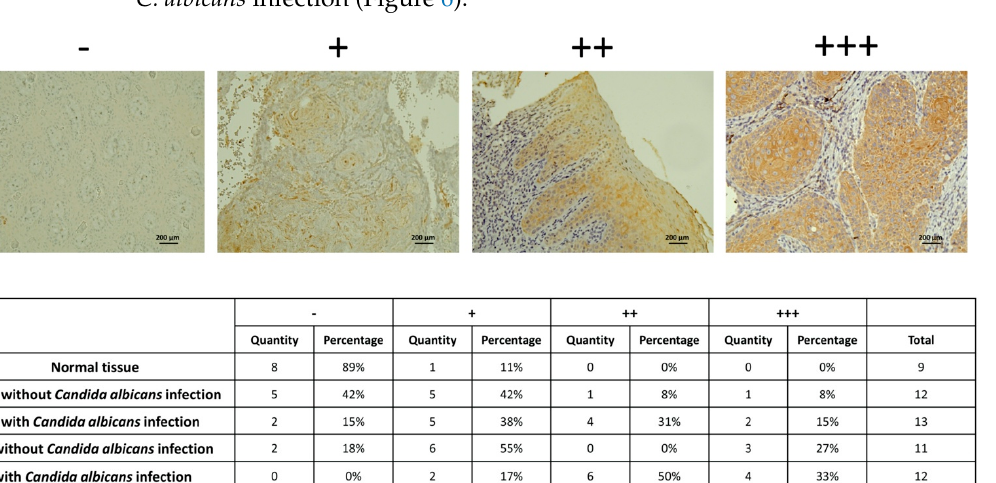
Figure 6. SFN significantly increased in OPMD lesions and OSCC tissues with Candida albicans in- fection. IHC staining data shows increased SFN expression in tissues with C. albicans infection, es- pecially OSCC tissue. SFN staining intensity was interpreted by two researchers. − means negative stain; + means weak stain; ++ means moderate stain; +++ means strong